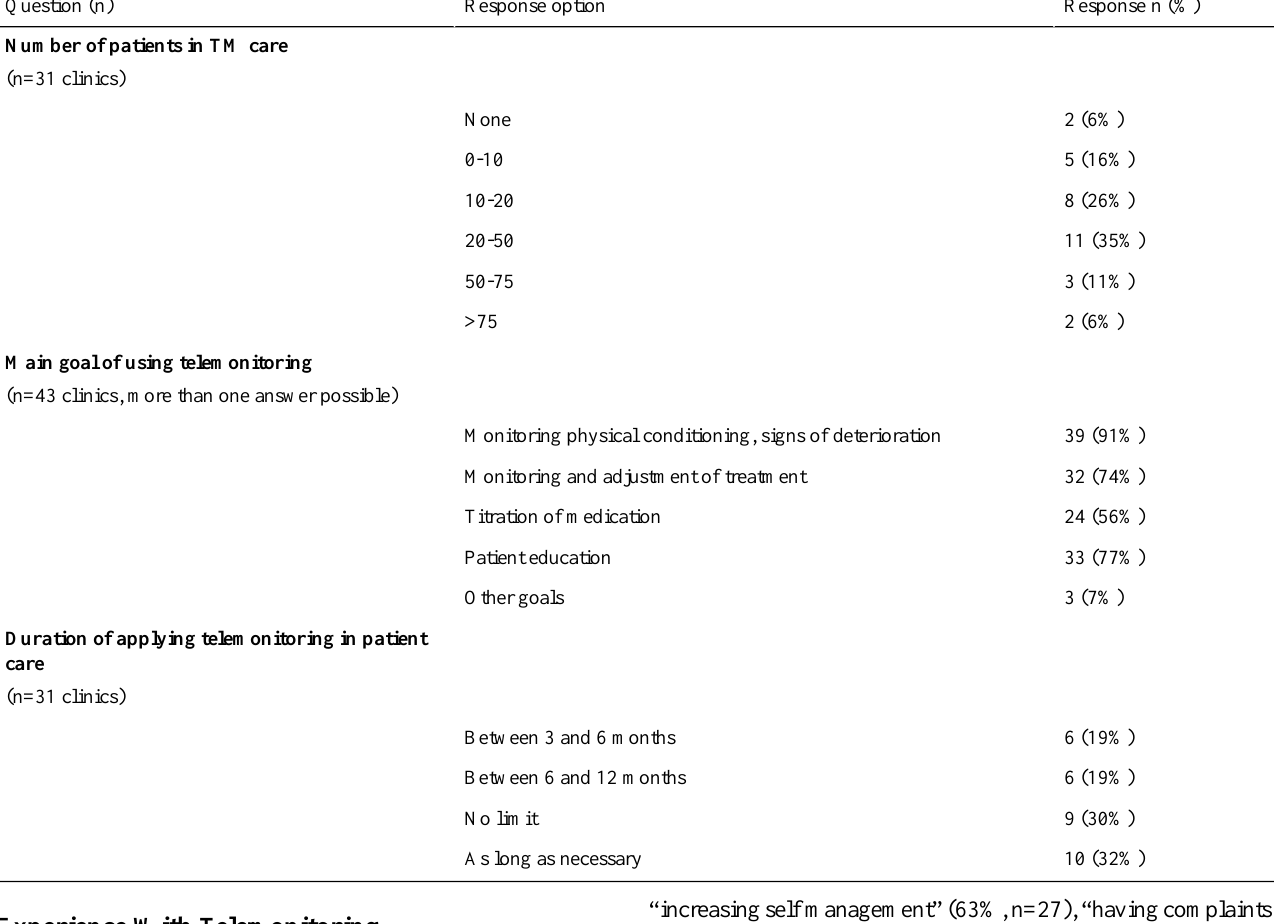
Table 3. General descriptive data of heart failure centers using (n=31) and planning to use (n=12) telemonitoring (TM).